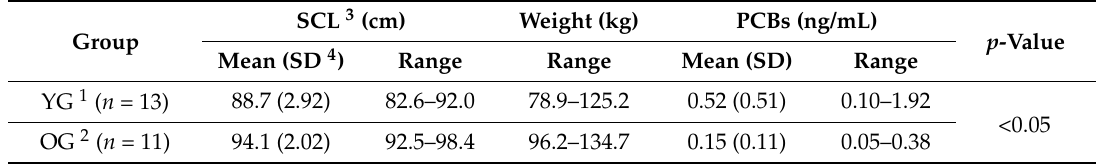
Table 2. PCBs concentration in plasma samples of female Hawaiian green turtle in different ages.